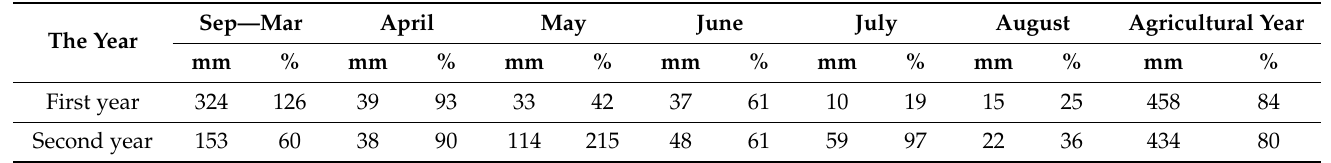
Table 4. The influence of the amount of precipitation in the first and in the second year for soybean and autumn wheat agricultural